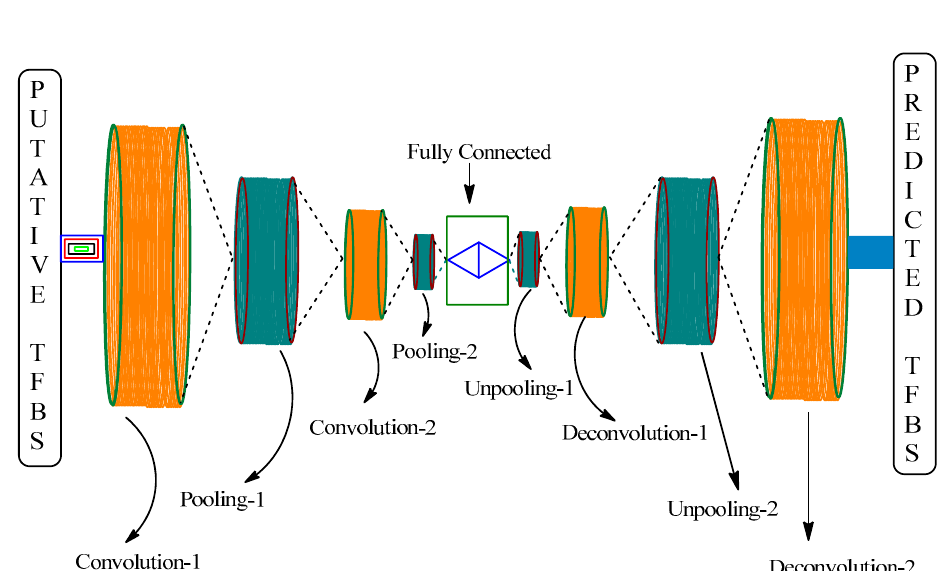
Figure 4. Graphical representation of a DeepSNR model.